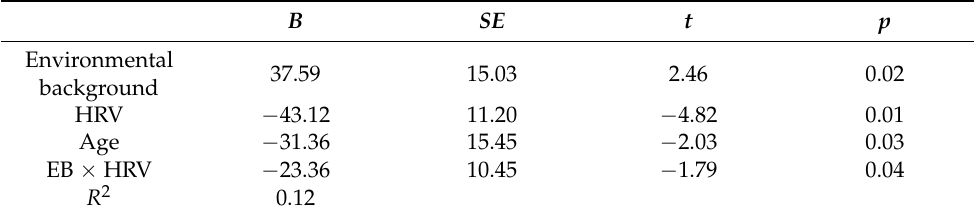
Table 1. Linear Regression for Children’s Emotional Interference.